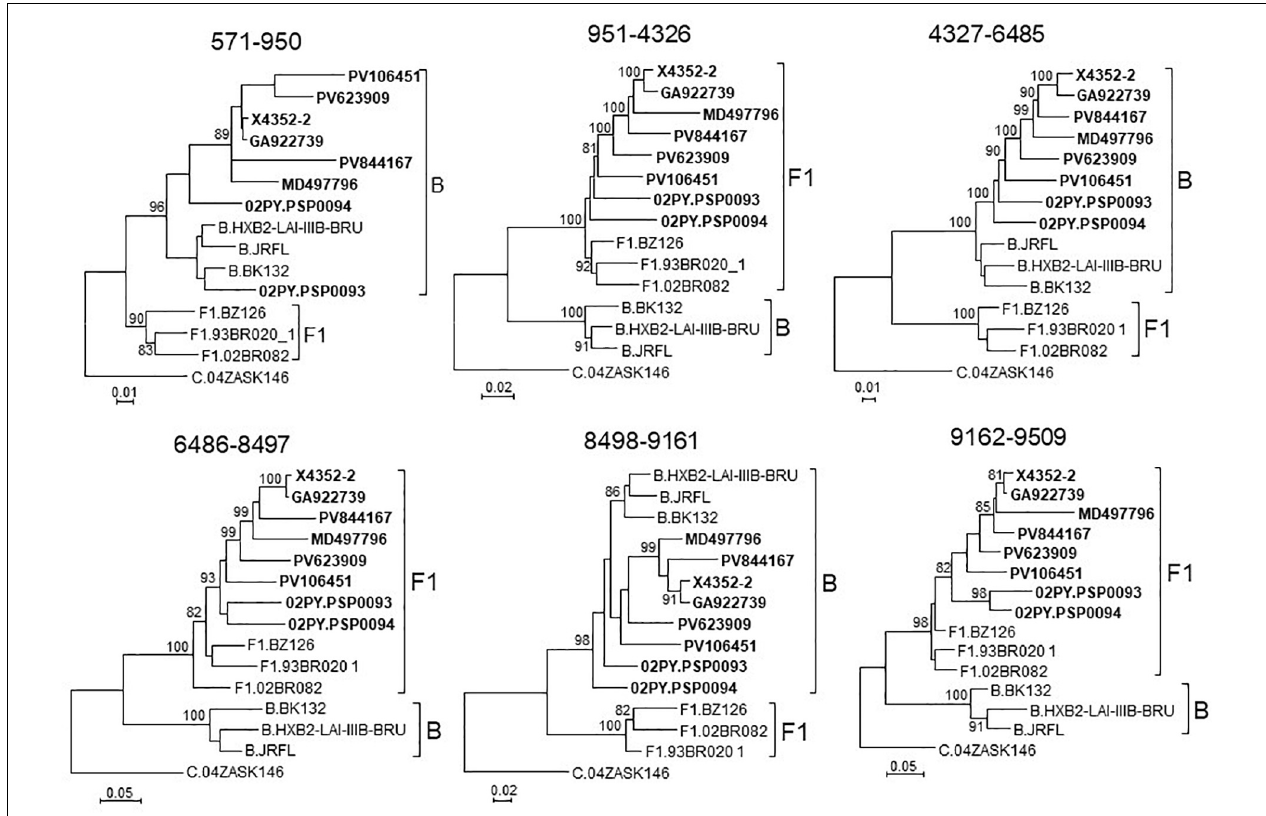
FIGURE 3 | Phylogenetic trees of interbreakpoint genome segments of the BF recombinant viruses analyzed by bootscanning, constructed with IQ-Tree. HXB2 positions delimiting the analyzed segments are indicated on top of the trees. Sequence names of BF viruses are in bold type. Names of subtype references are preceded by the corresponding subtype name. Only ultrafast bootstrap values ≥ 80% are